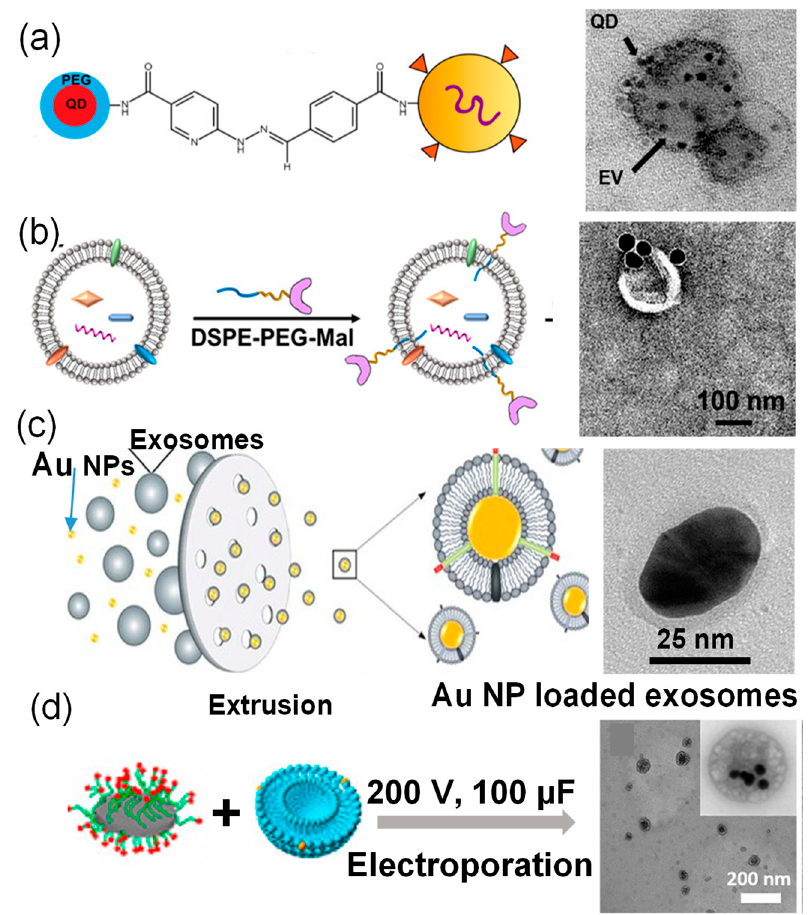
Figure 2. Examples of inorganic nanoparticle (NP)-loaded exosomes post exosome formation with schematic drawings and TEM images: ( a ) QD-loaded exosomes through chemical linker conjugation, [25] ( b ) Au NP-loaded exosomes through lipid infused linkers, [26] ( c ) Au NP-loaded exosomes through extrusion, [28] and ( d ) V 2 C DD-loaded exosomes via electroporation [30].